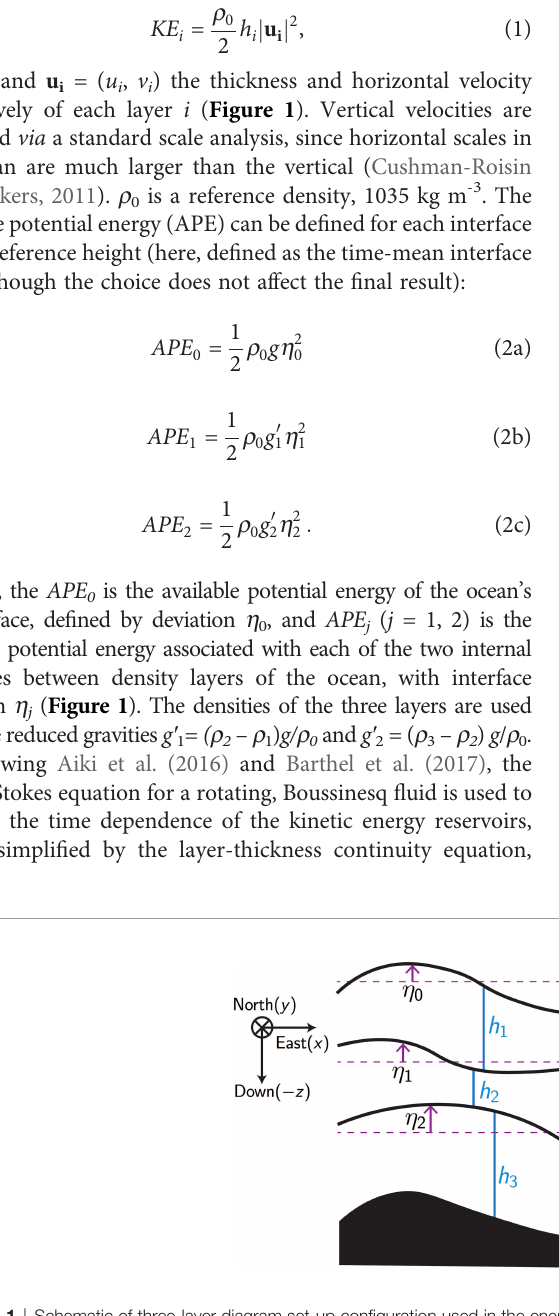
FIGURE 1 | Schematic of three-layer diagram set-up con fi guration used in the energy conversion framework described in energy conversion framework. Layer i = 1 is at the top and layer i = 3 is at the bottom, so that r 1 < r 2 < r 3 . Layer thicknesses h i , horizontal velocities u i , interface deviations n j and corresponding available potential energy APE j for each interface are